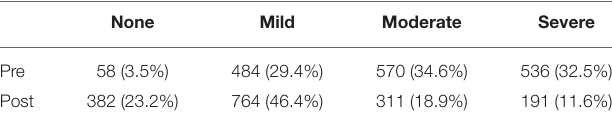
TABLE 1 | Classification of anxiety symptoms pre- and post-intervention (% of participants in each classification using GAD-7).